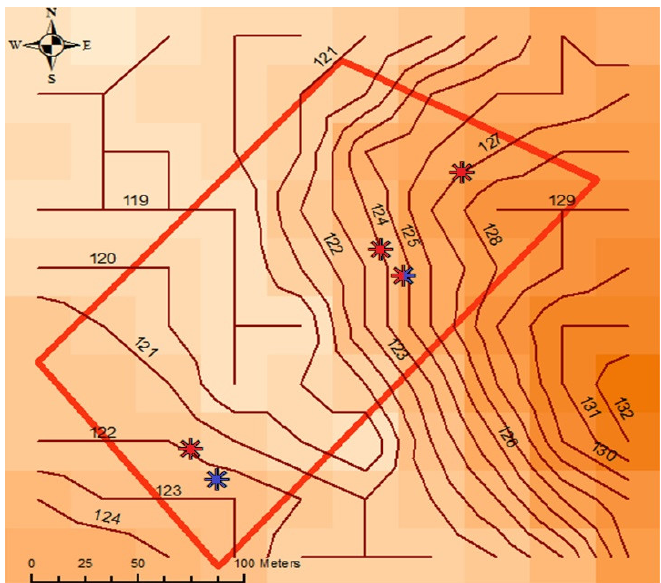
Figure 2. Topographic map of the field (source: Open Topography). (Blue star, 2015–2016; red stars, 2016–2017; red/blue, star both growing seasons.).